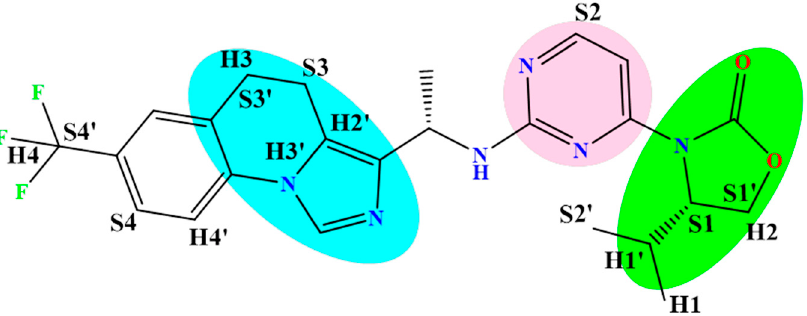
Figure 2. The steric (S and S ′ ) and hydrophobic (H and H ′ ) modification of favorable and non-favorable functional points in reference compound (RC-01). The green represents the oxazolidine moiety, pink represents the pyrimidine moiety, and cyan represents the imidazole moiety.